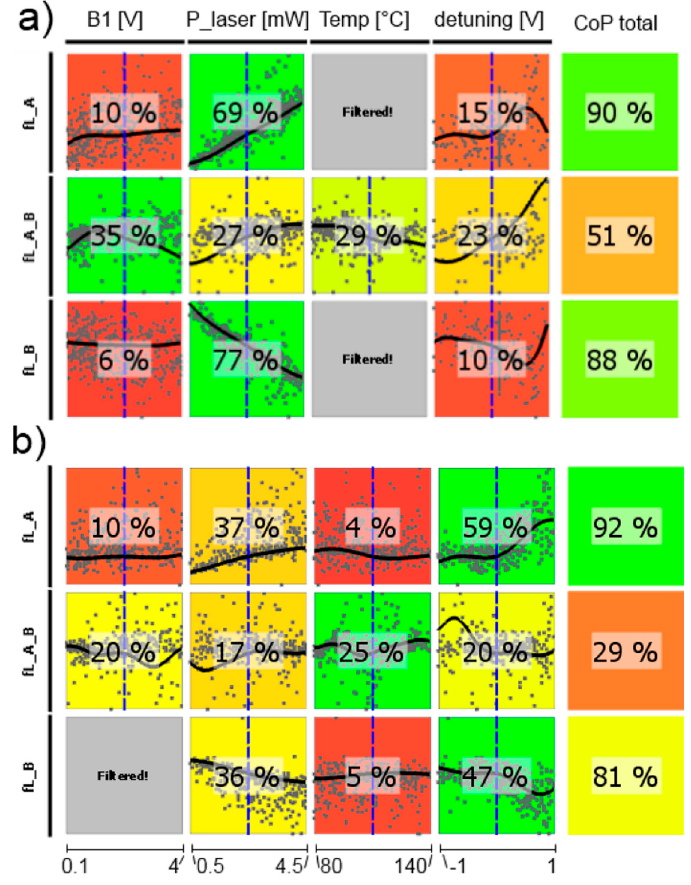
Figure 12. CoP matrix of the resonance frequencies. ( a ) high-pressure magnetometer; ( b ) medium-pressure magnetometer. Approximation technique: ( a ) fL_A moving least squares; all others isotropic kriging.